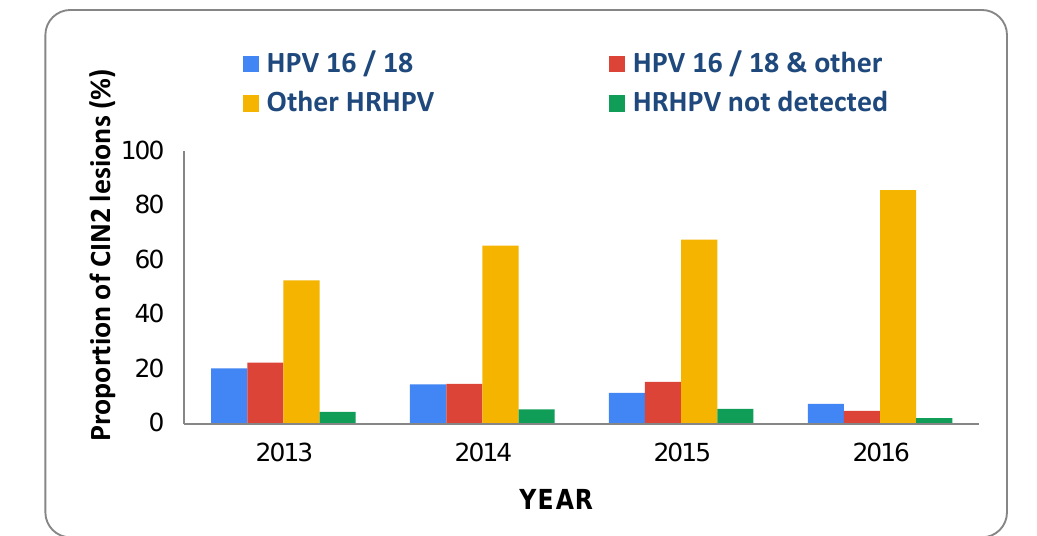
Figure 4. CIN 2-associated HPV types detected in New Zealand women from 2013 to 2016.